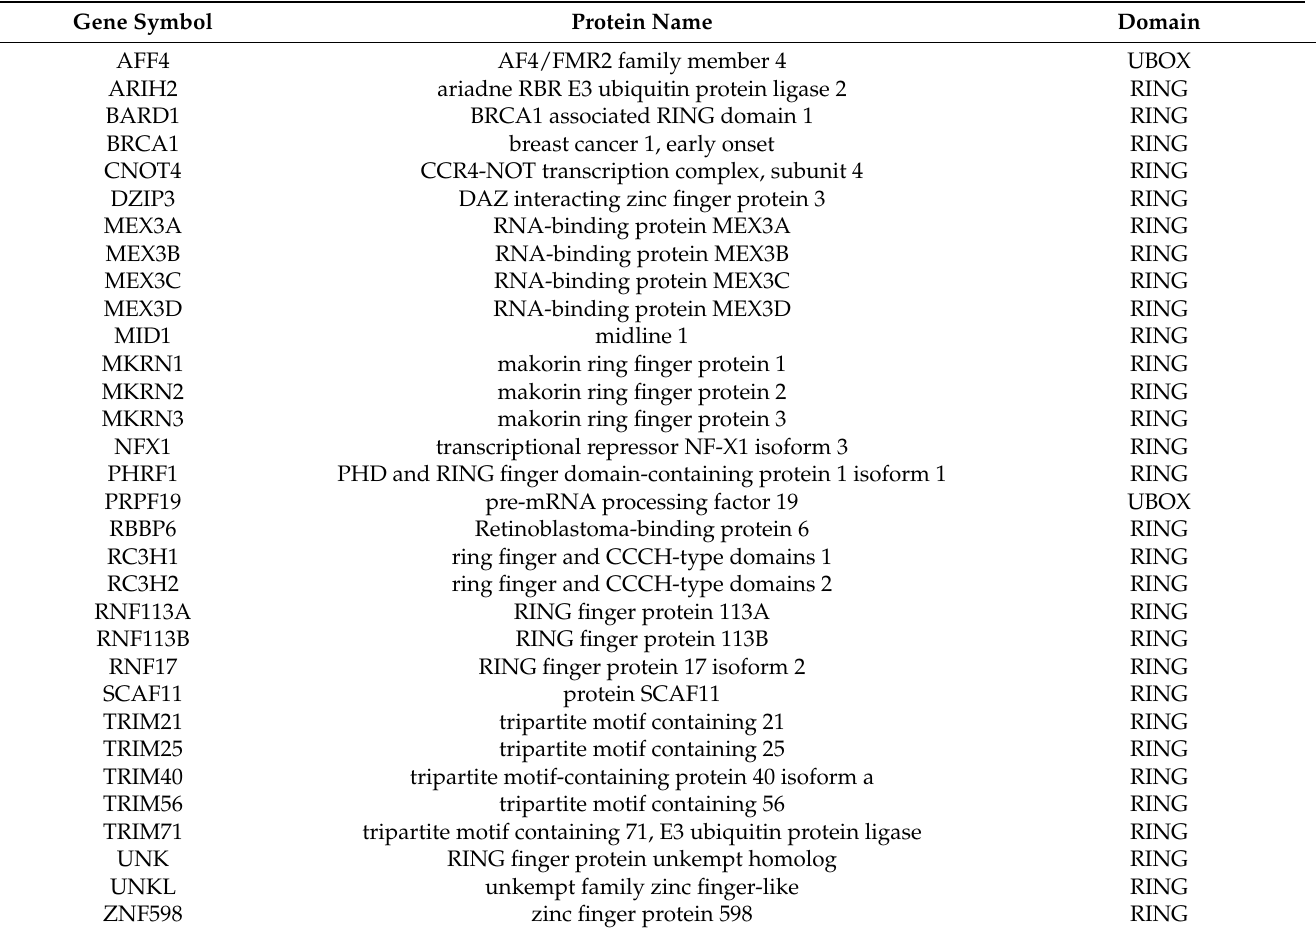
Table 1. E3 Ligase domain containing